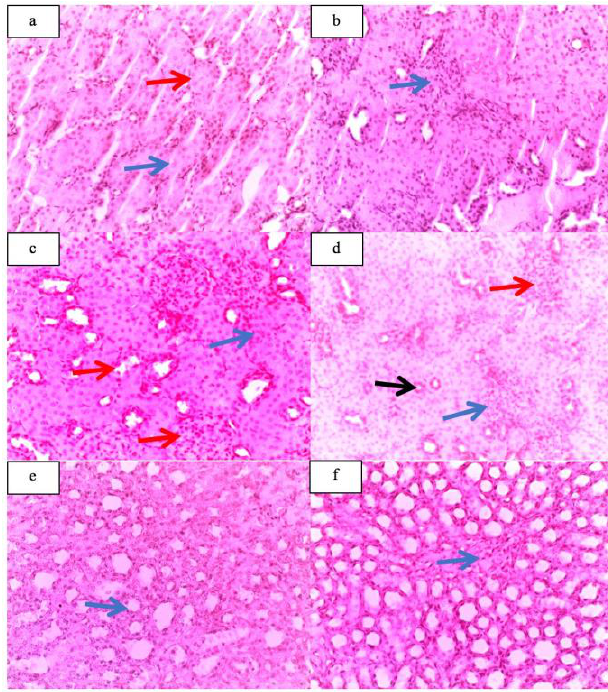
Fig. 5: Histopathological examination of the rat kidney (a- f). (a & b) group 6 of rats with 500 mg/kg, (a) showing severe degenerative changes of renal tubules blue arrow, swelling of cells lining of renal tubules red arrow and (b) showing severe inflammatory changes of glomeruli as narrowing of bowman's space indicating glomerular hypertrophy blue arrow. Group 5 at 500 mg/kg, showing moderate infiltration of inflammatory cells of the interstitial tissues blue arrow and moderate degenerative changes of tubules and glomeruli red arrow (c). Group 4 at 500 mg/kg, showing diffuse glomerulitis blue arrow, interstitial nephritis, red arrow and atrophy of some of the tubules, the black arrow (d). Group 3 at 250mg/kg, showing mild degenerative changes of most renal tubules blue arrow(e). Group 2 at 100mg/kg, showing most renal tubules appear normal structure and mild thickening of intestinal tissue, a blue arrow(f). H&E, 400